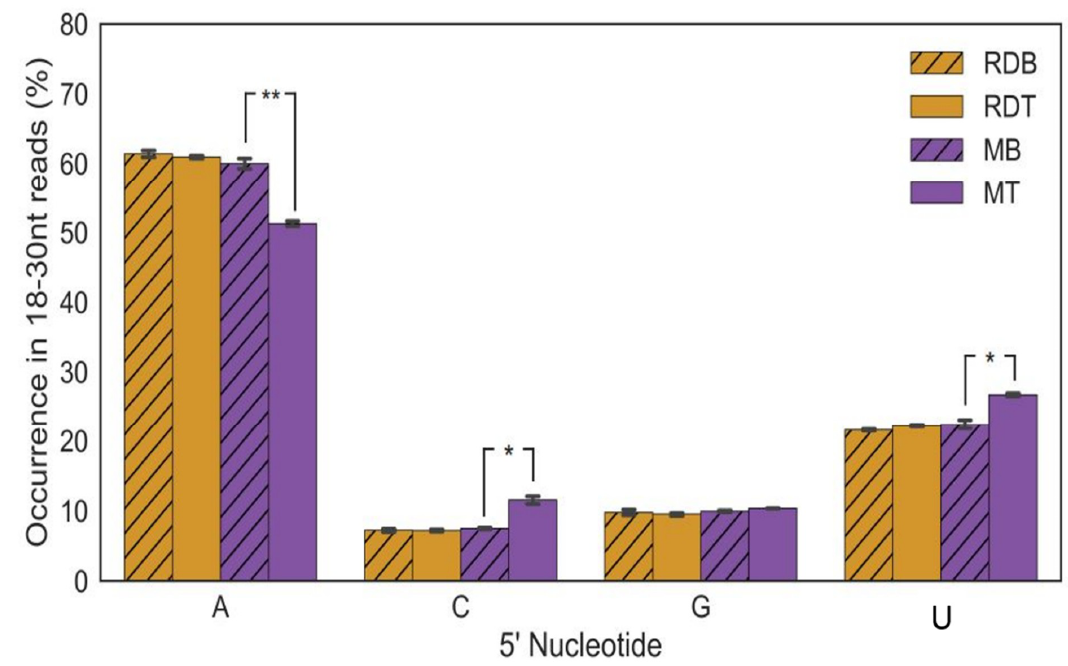
Figure 6. Percentage of tomato spotted wilt virus (TSWV) siRNA 5′ nucleotide enrichment. Purple corresponds to tomato Marglobe, the susceptible genotype Sw-5(−), while the yellow line corresponds to Red Defender, the resistant genotype, Sw-5(+). There is no difference in 5′ nucleotide enrichment among vsiRNAs, but there are significant changes in small RNAs between mock- and TSWV-inoculated Marglobe. RDB: Bu ff er-inoculated Red Defender (Mock); RDT: TSWV-infected Red Defender; MB: Bu ff er-inoculated Marglobe (Mock); MT: TSWV-infected Marglobe. Pairwise t-tests with